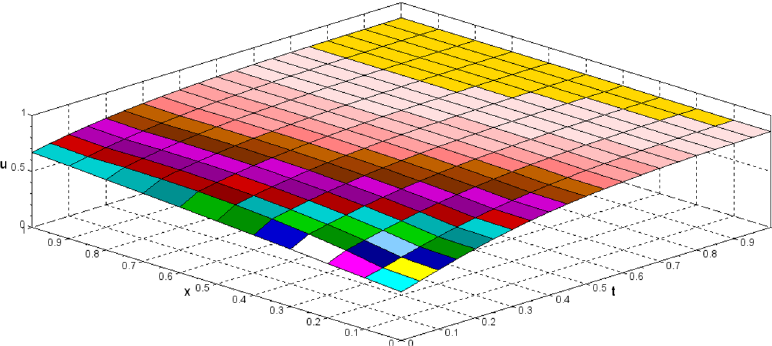
Fig. 3 (I-EFD) solution of Example 5.2 for (cid:2) t = 0 . 001 and (cid:2) x = 0 . 05